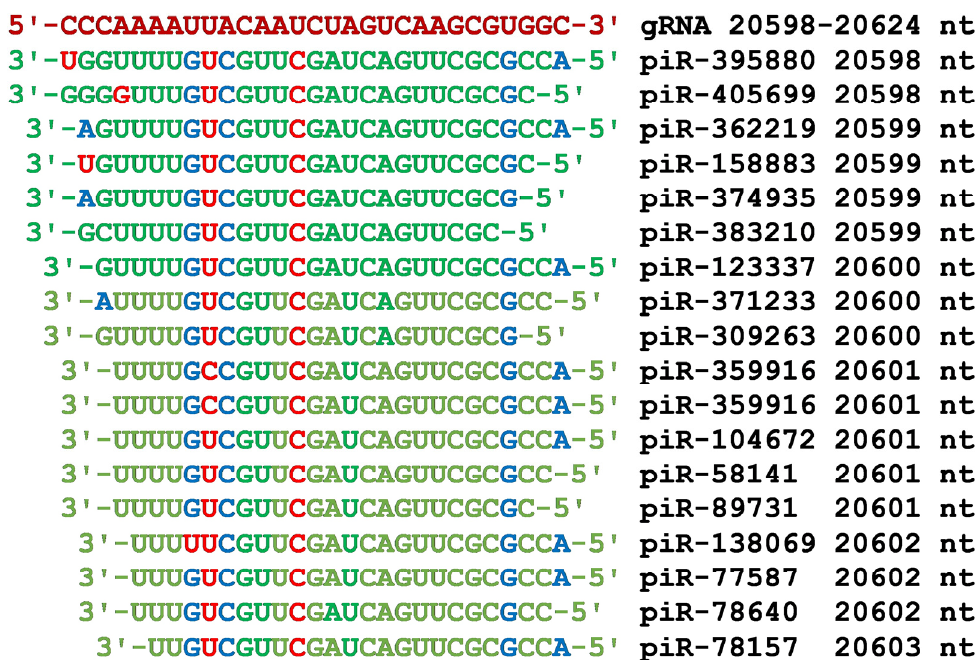
Figure 9. Nucleotide sequences of the piRNA BSs cluster in the region of gRNA from 20,598 nt to 20,624 nt and the nucleotide sequences of piRNAs. Note: The piRNA nucleotides that form canonical pairs with gRNA are highlighted in green and non ‐ canonical pairs are highlighted in blue. The piRNA nucleotides that do not interact with gRNA are highlighted in red. The names of the piRNAs are followed by the beginning of their BSs.